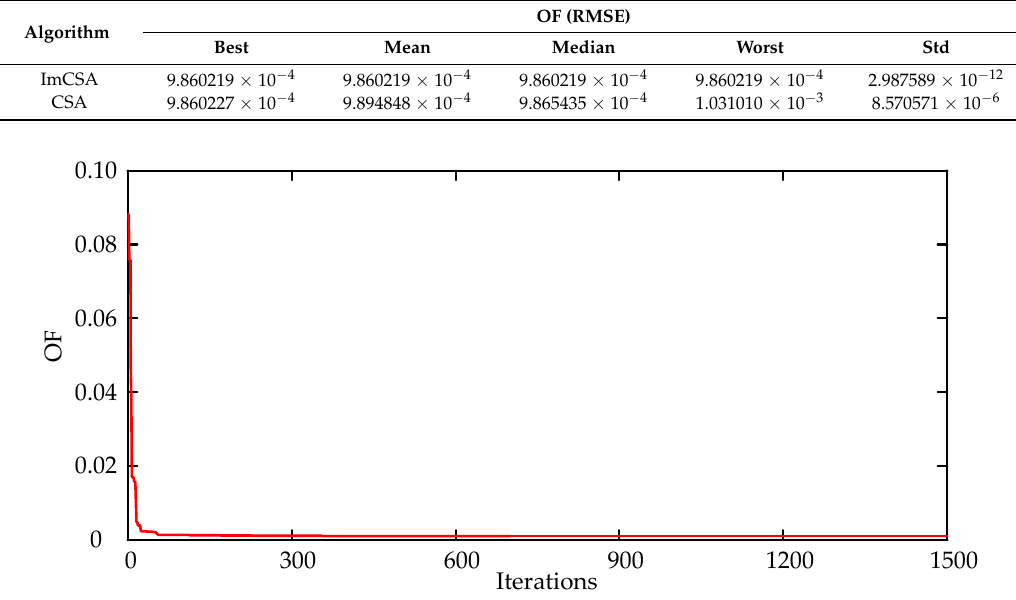
Figure 4. Convergence characteristic of the proposed ImCSA for parameter estimation of the SDM of RTC France silicon solar cell.